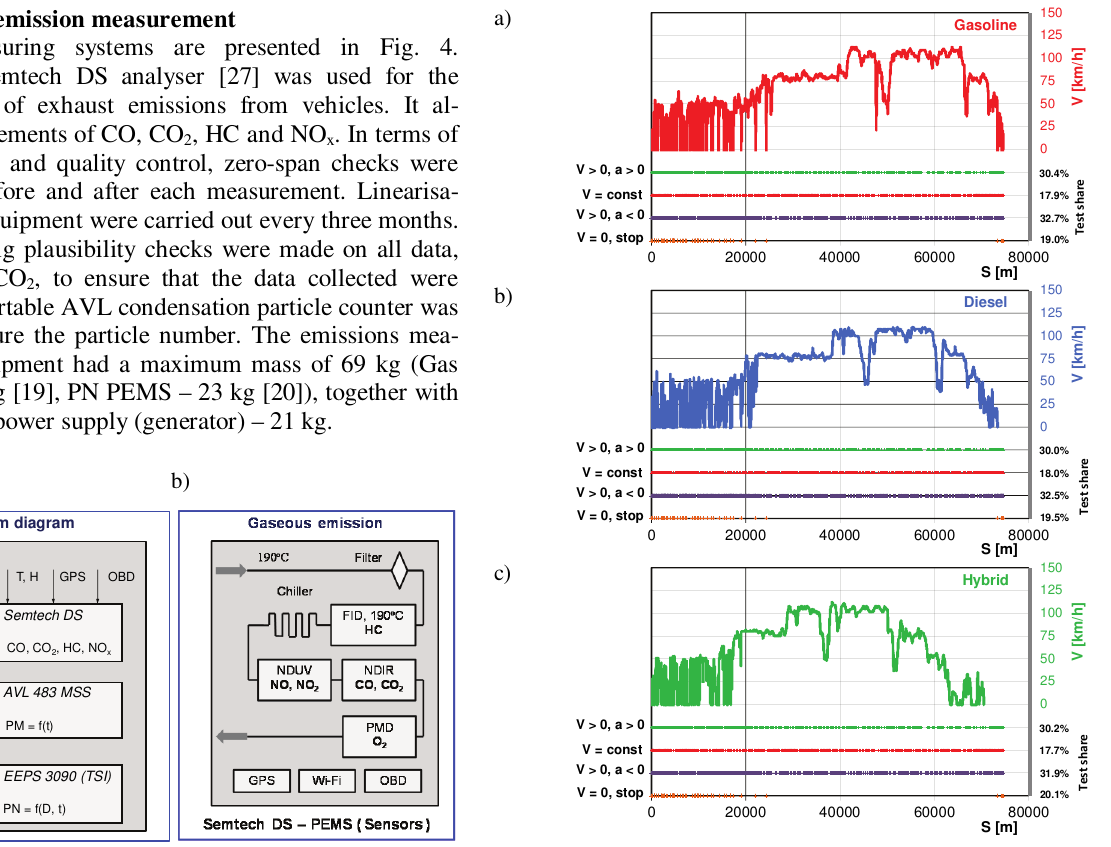
Fig. 5. Velocity profiles and vehicles parameters of motion Fig. 4. The measuring systems used for testing under real driving condi- tions The analysis of test distance data in rural portion showed that the tests of the vehicles fitted with gasoline and diesel engines were characterized by the longest distance travelled (25.1 km) and the test of the hybrid vehicle with the shortest (24.7 km). The values of the distance covered for all test drives within the acceptable range, i.e. they were more than 16 km (Fig. 6b). The distance travelled in mo- torway portion of the test was the longest for the vehicle with the hybrid drive (23.5 km) and the shortest for the test of vehicle fitted with diesel engine (21.7 km). The values of the distance covered for all test drives within the permissi- ble range, i.e. they were more than 16 km (Fig.